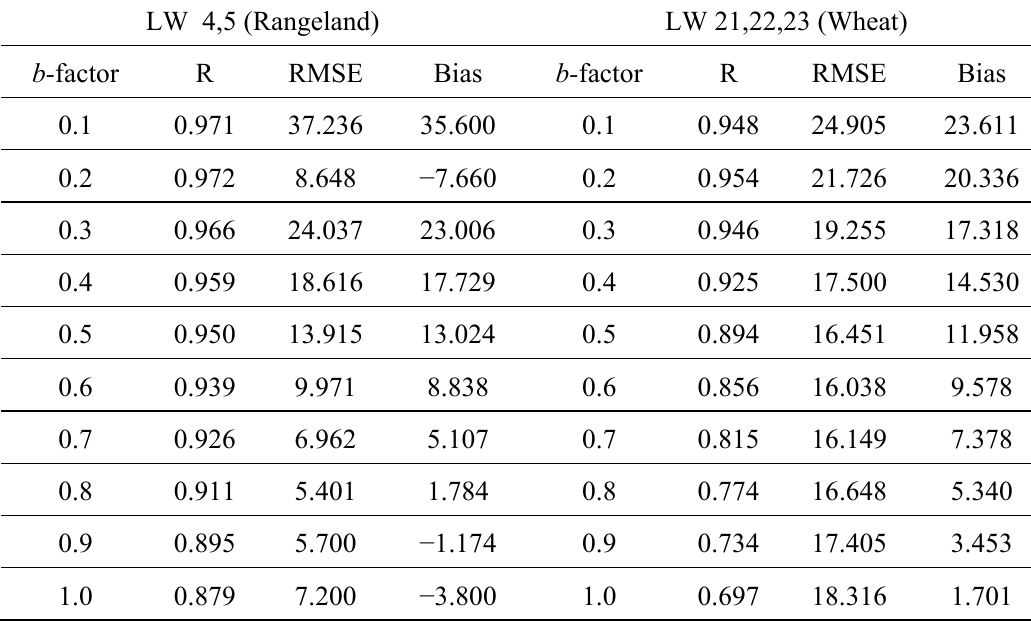
Table 6. Correlation coefficient (R), Root Mean Squared Error (RMSE), and bias values at b- factors (from 0.1 to 1.0) in LW 4, 5 and LW 21, 22,